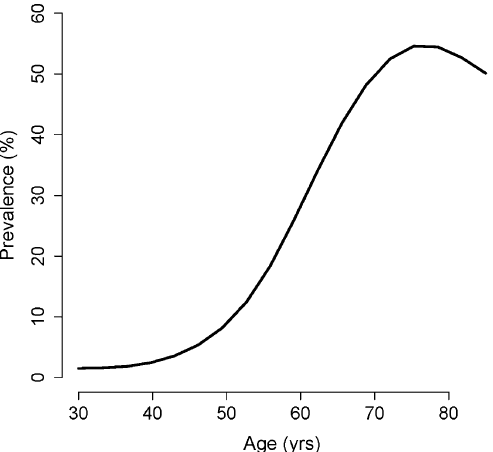
Figure 3. The prevalence of the disease for each age. The values were obtained from subset analysis of data of men aged 20–39, 40–49, 50–59, 60–69, 70–79, and ≥ 80 years. The prevalence came directly from the curve